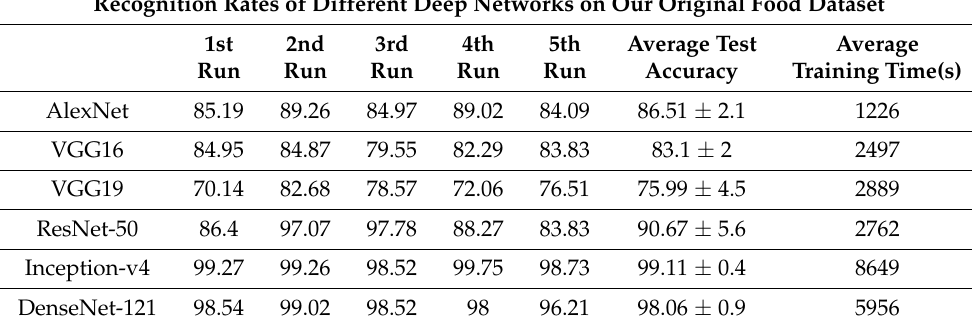
Table 3. Validation accuracy with different CNN models on training image